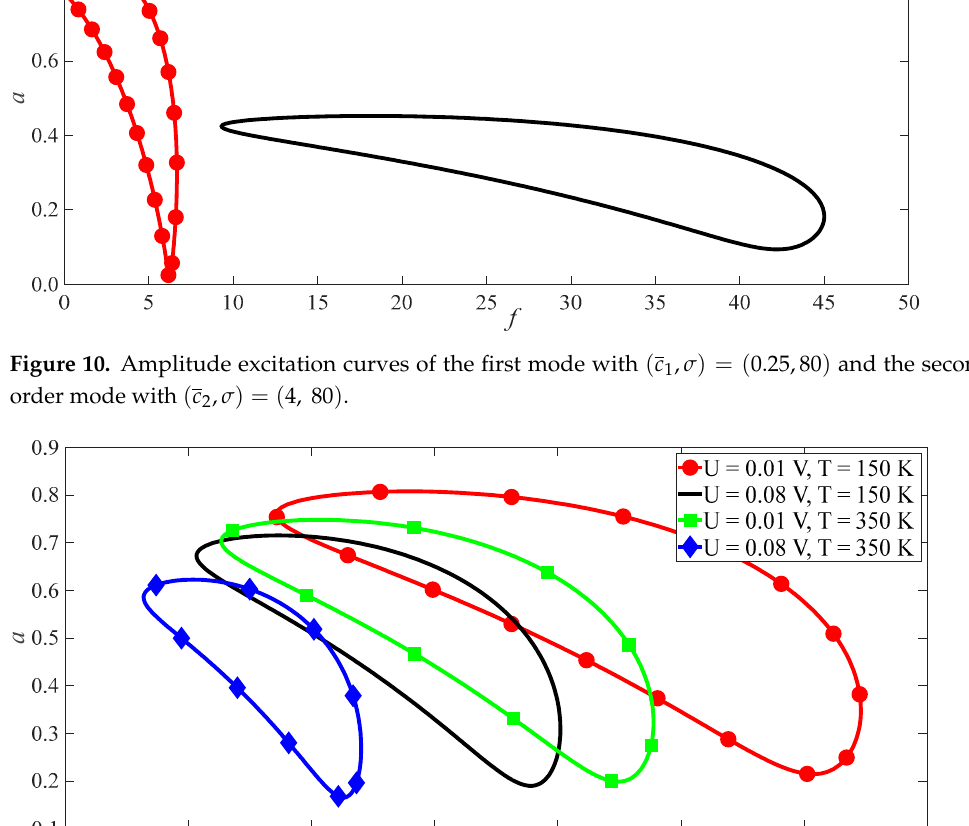
Figure 11. Effect of temperature and electric fields on the amplitude of first mode for ( c 1 , σ ) = ( 5,80 ) .